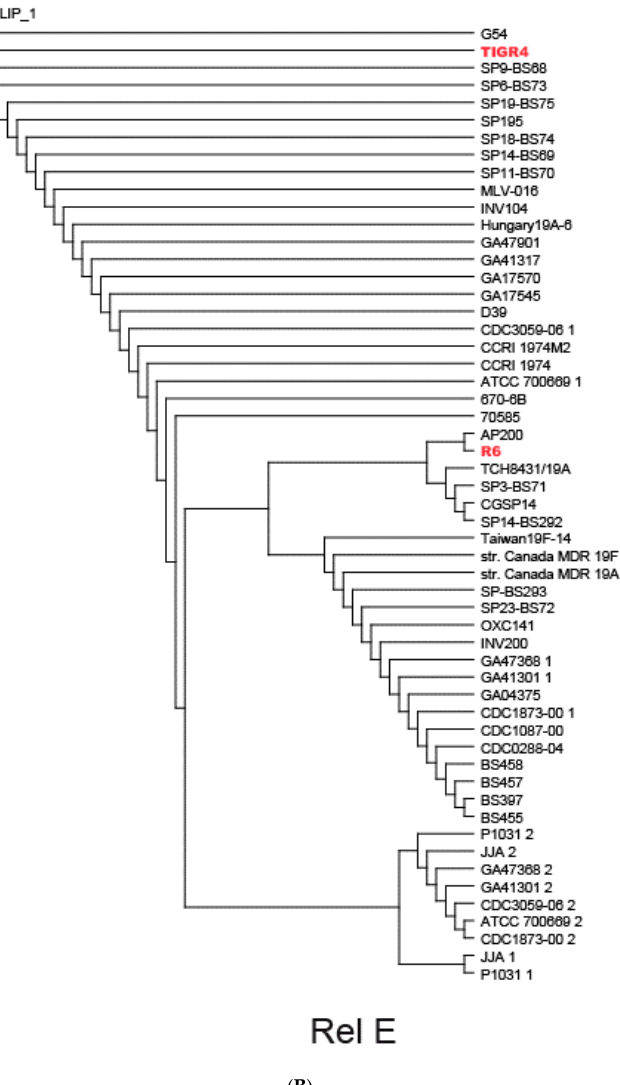
Figure 2. ( A ). Alignment of RelE proteins different pneumococcal strains. BLASTp using the pneumococcal RelE amino acid sequence from strain R6 as query retrieved 74 RelE alleles, of which we selected the 40 depicted ones as representatives of the best-characterized strains [41]. Three groups were found with 87, 84, and 87 residues, respectively. The first group (87 residues) varied significantly from the other two, with amino acid changes scattered around the protein sequence (see the conservation diagram, in yellow, below). The second sets of RelE proteins have 84 residues, in which strain TIGR4 is included (red letters). The last six strains (87 residues long) showed the RelE proteins having an MNN N-terminal extension, the group represented by strain R6 (red letters). However, these three N-terminal residues were present only in 5% of the purified pneumococcal protein, whereas the 95% rest lack these three residues, as determined by MALDI assays (Figure 1B and Supplementary Figure S1). Below the alignments, the conservation and quality (yellow), the consensus (black) and the occupancy (grey) are depicted in a diagram from the Jalview 2.0 program [51]. ( B ). Phylogenetic tree of the 40 selected pneumococcal toxins RelE generated by CLUSTAL Omega program (five iterations). The positions of the toxins in the two most representative pneumococcal strains, R6 and TIGR4, are indicated in boldface red letters.